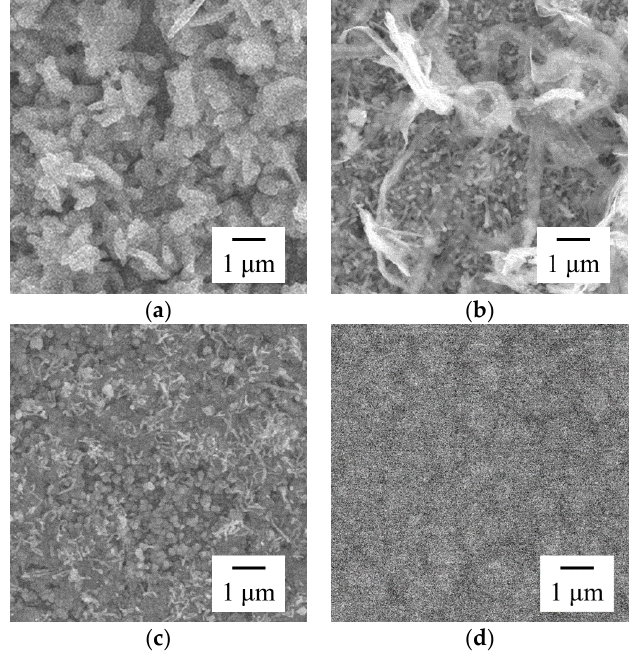
Figure 6. SEM images of the Zn–Fe–Mo plating deposited at various current densities. ( a ) 1 mA cm −2 ; ( b ) 2 mA cm −2 ; ( c ) 5 mA cm −2 ; and ( d ) 10 mA cm −2 .